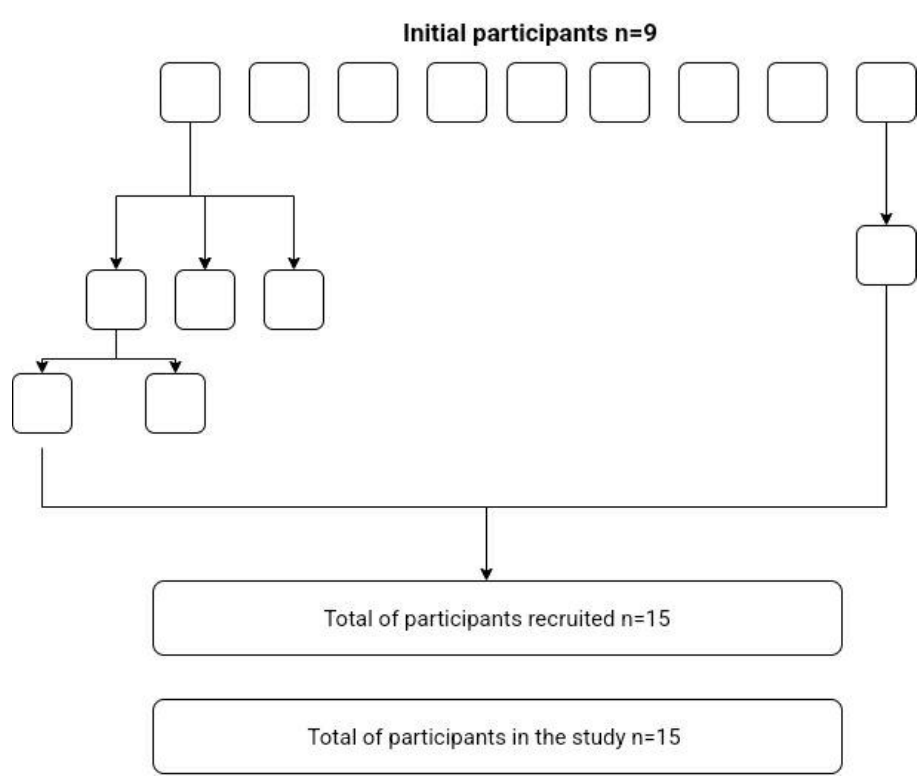
Figure 1. Process of recruiting participants.